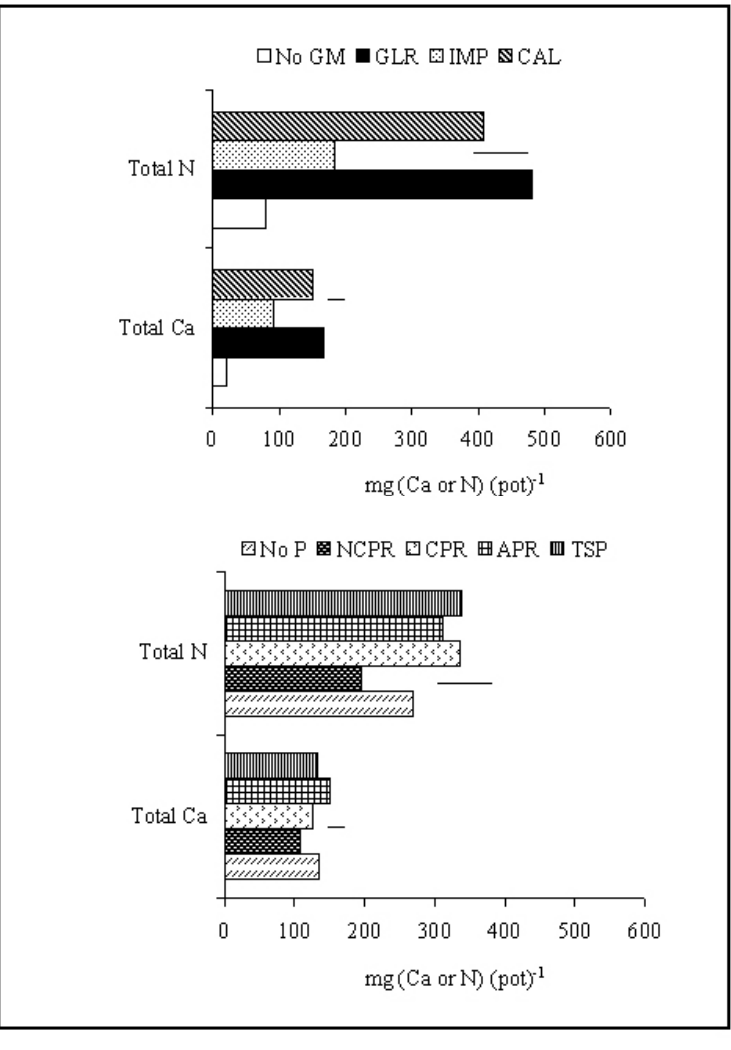
FIGURE 10. Uptake of N and Ca by Setaria sphacelata after 20 weeks growth in a tropical soil treated with GMs and P fertilizers. Horizontal lines = LSD 0.05